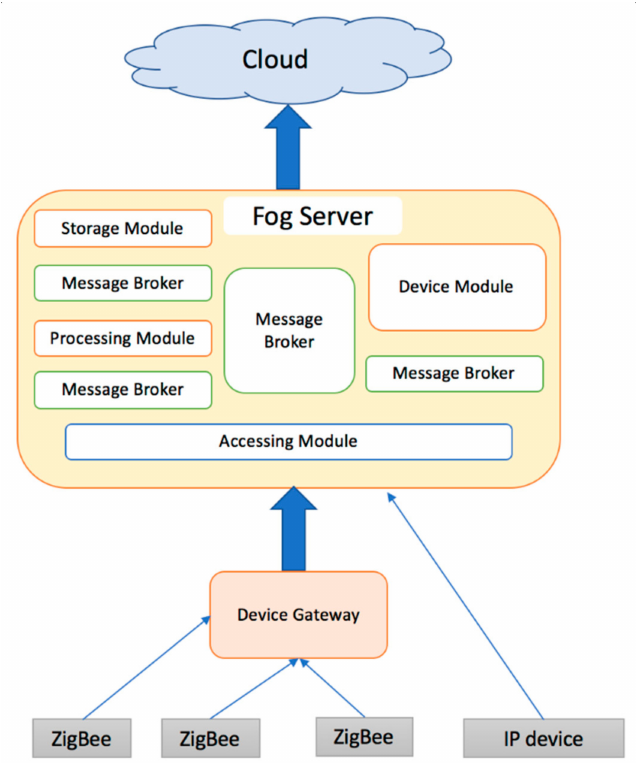
Figure 1. Conceptual architecture of the proposed